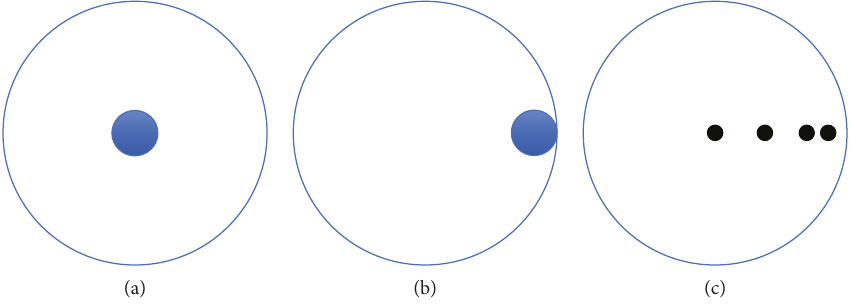
Figure 8: Schematic diagram of fl uid element motion under zero gravity with the tank moving left. Fluid element in motion relative to the tank (a), fl uid element in contact with the tank wall prior to distortion (b), and movement of the centre of mass at equal time steps (c).